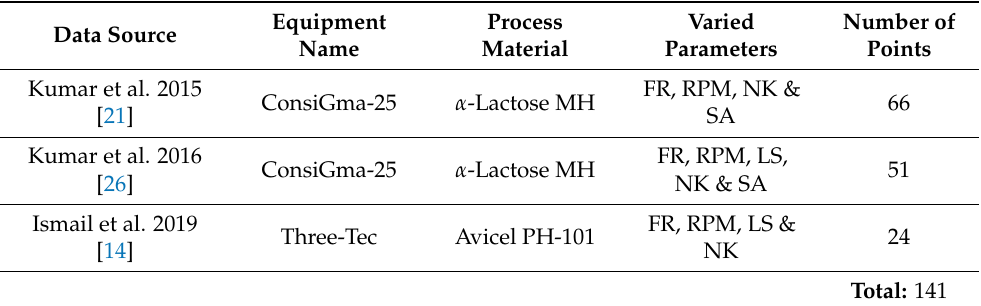
Table 1. Summary of the twin screw wet granulation residence time distribution (RTD) available and collected from the